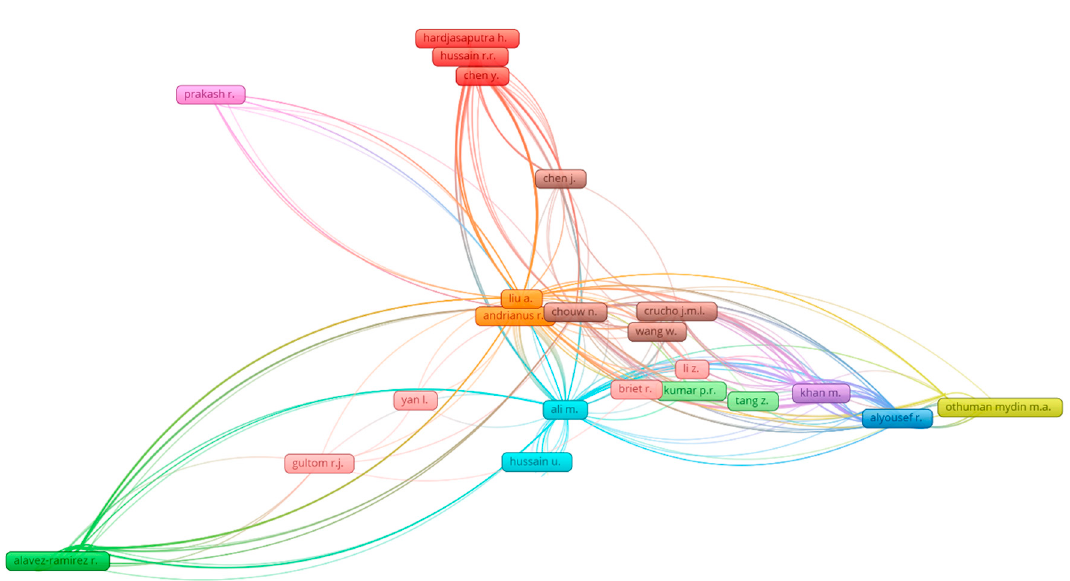
Figure 9. Scientific visualization of authors that published articles in the related research area.